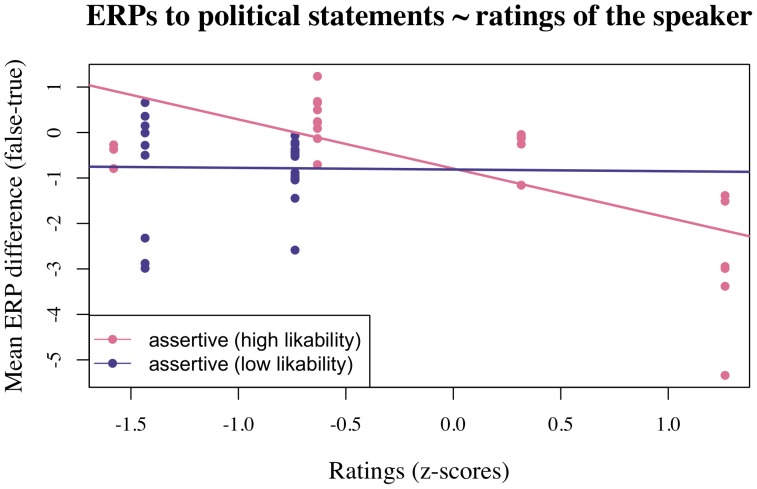
Effect of by-participant assertiveness ratings for the political speaker on the TRUE-FALSE effect for political statements in the right-anterior region in Experiment 1.Higher N400 amplitudes correlated with higher assertiveness judgements for those participants who judged the political speaker to be of above-median likability.